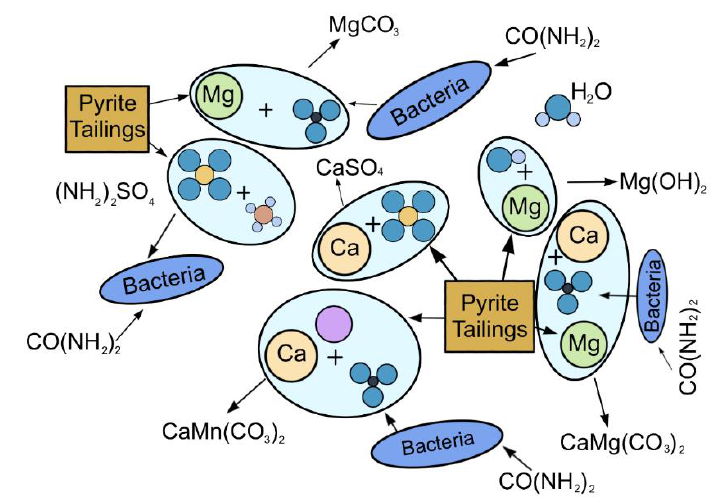
Figure 12. Schematic diagram of the mechanism of MICP solidified pyrite tailings.